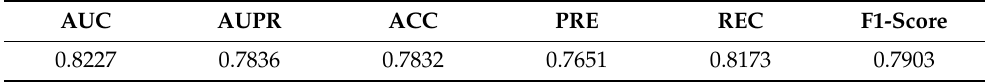
Table 5. Results of the GGCDA on the independent test set.